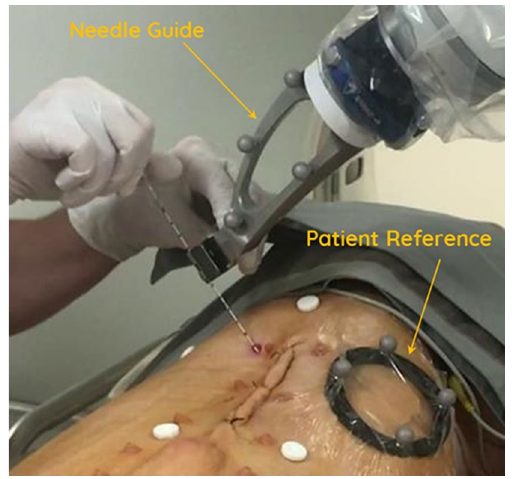
Figure 1. Example of a robotically-assisted needle